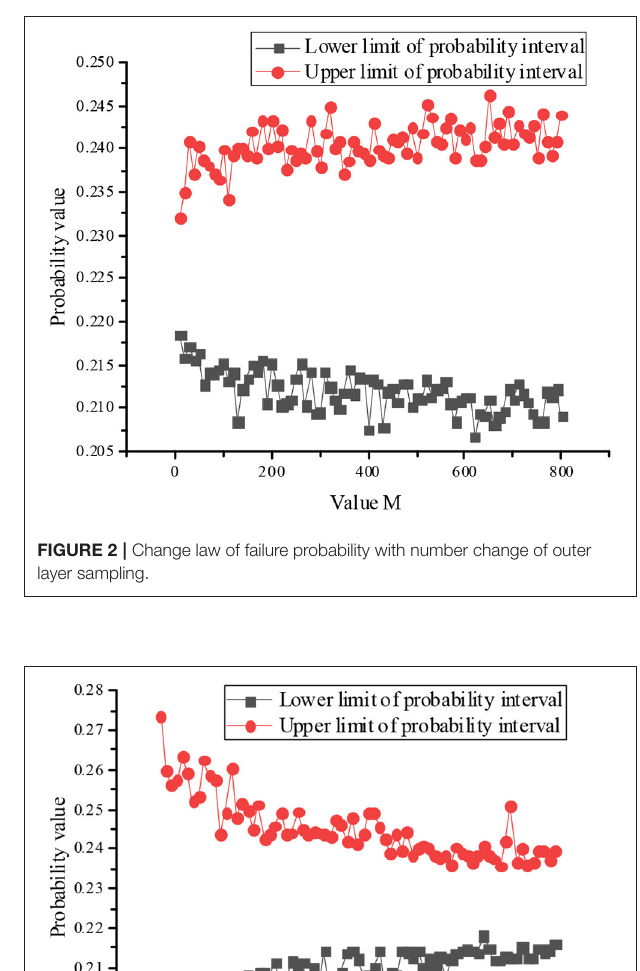
TABLE 2 | Event probability of each layer.